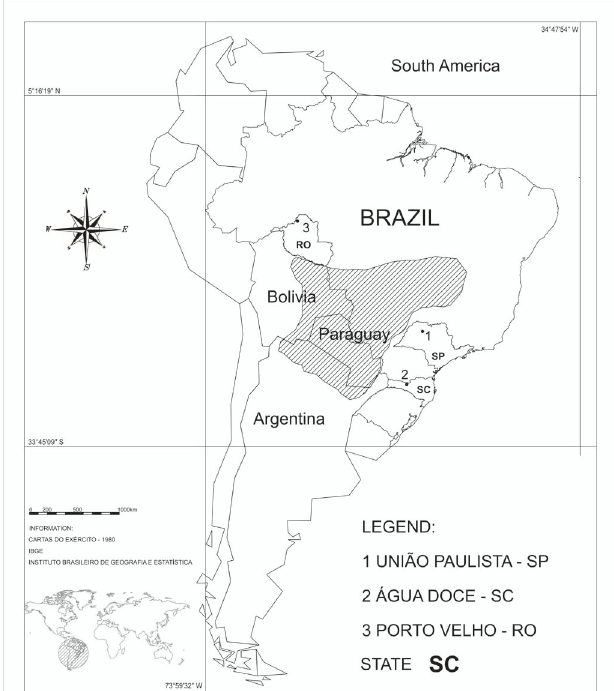
Figure 1. Phyllomedusa azurea et al. New record of in the (1) municipality of União Paulista, state of São Paulo (Prado 2008), (2) municipality of et al. Água Doce, state of Santa Catarina (present study), and (3) municipality of Porto Velho, state of Rondônia (Calderon 2009). The stripped area corresponds to the species geographic distribution proposed by Angulo (2008).